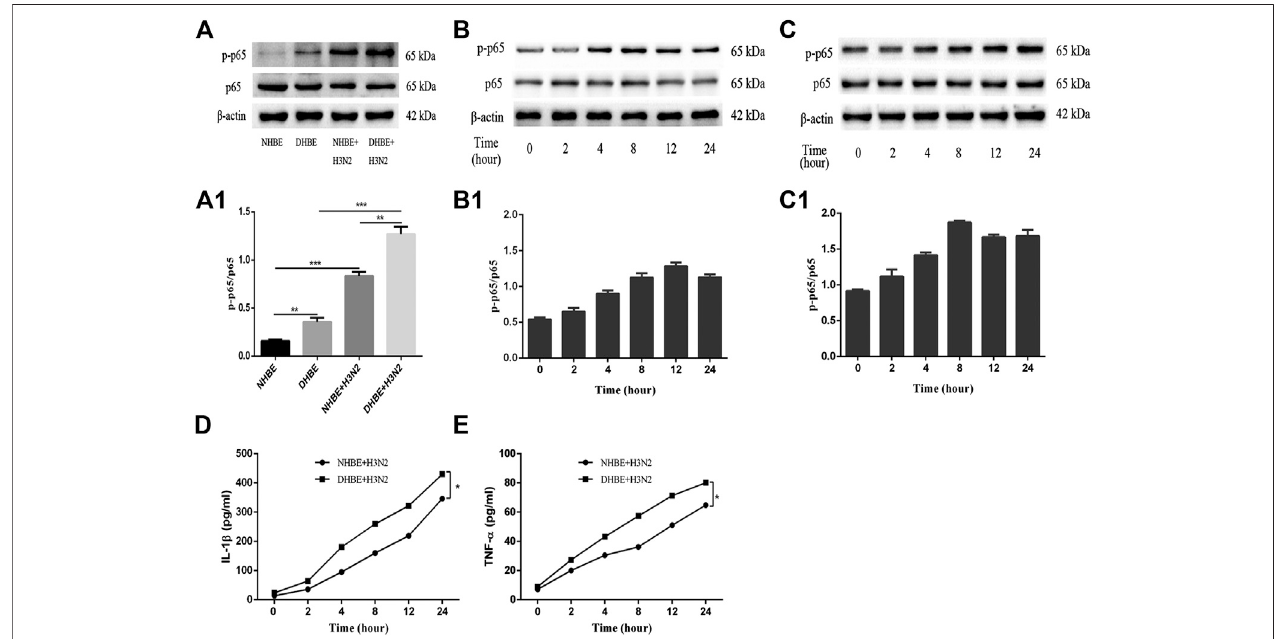
FIGURE 1 | IAV activated the NF- κ B pathway in pHBECs. (A,A1) The protein expression and relative intensity of NF- κ Bp65 and phospho-p65 in pHBECs after infection with or without IAV for 24 h. (B,B1) The time-dependent protein expression and relative intensity of NF- κ Bp65 and phospho-p65 in NHBE after infection with IAV. (C,C1) The time-dependent protein expression and relativeintensityofNF- κ Bp65 and phospho-p65 in DHBEafter infection withIAV. (D,E) ELISAanalyses ofIL-1 β and TNF- α in pHBECs after infection with IAV (* p ＜ 0.05). Each dataset comprises three independent